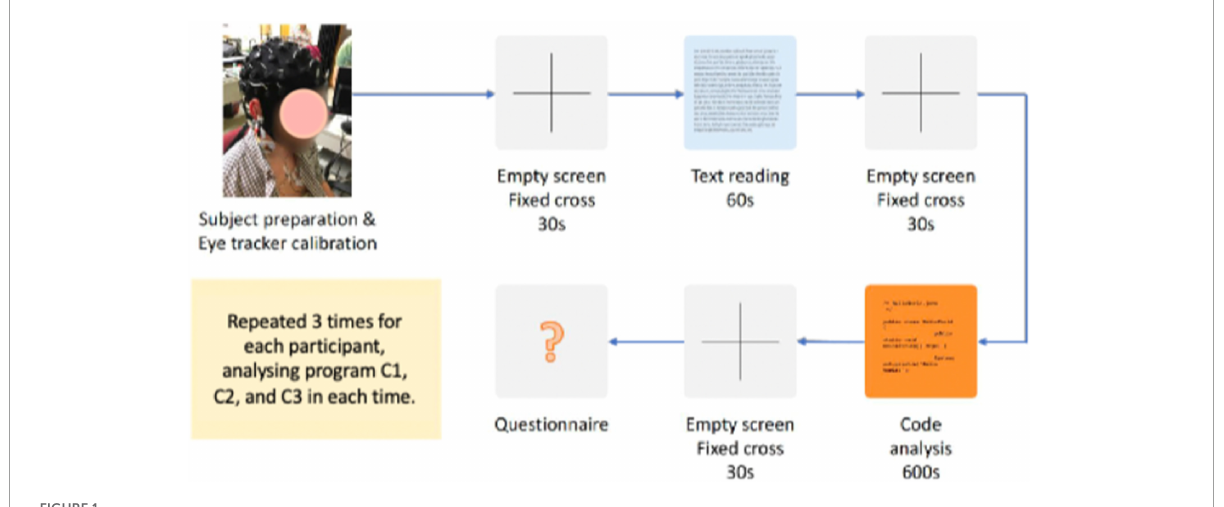
FIGURE1 Sequence of steps for each trial of program